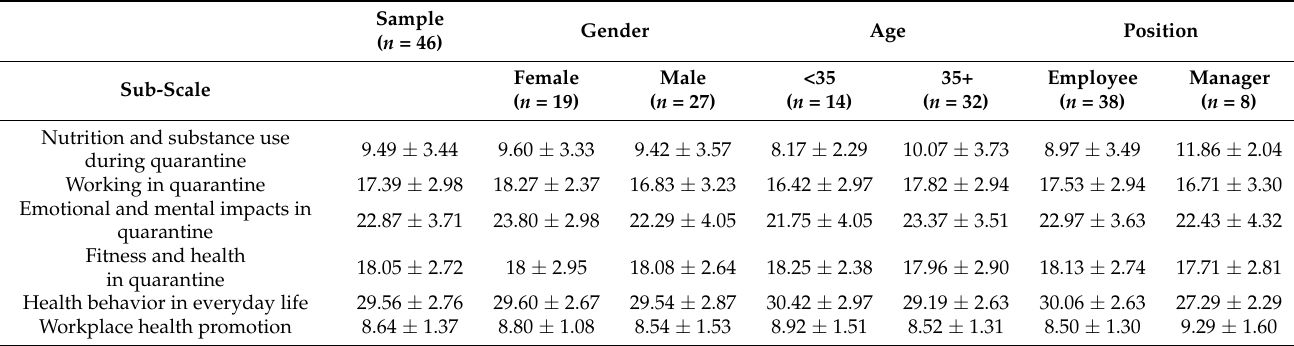
Table 7. Descriptive statistics of the subscales regarding background factors (mean ± SD).